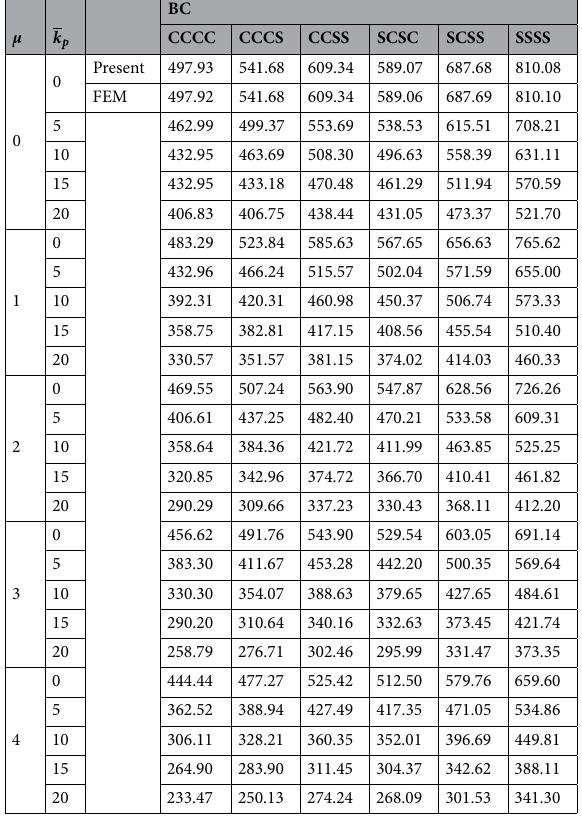
Table 4. Bending deflections, 10